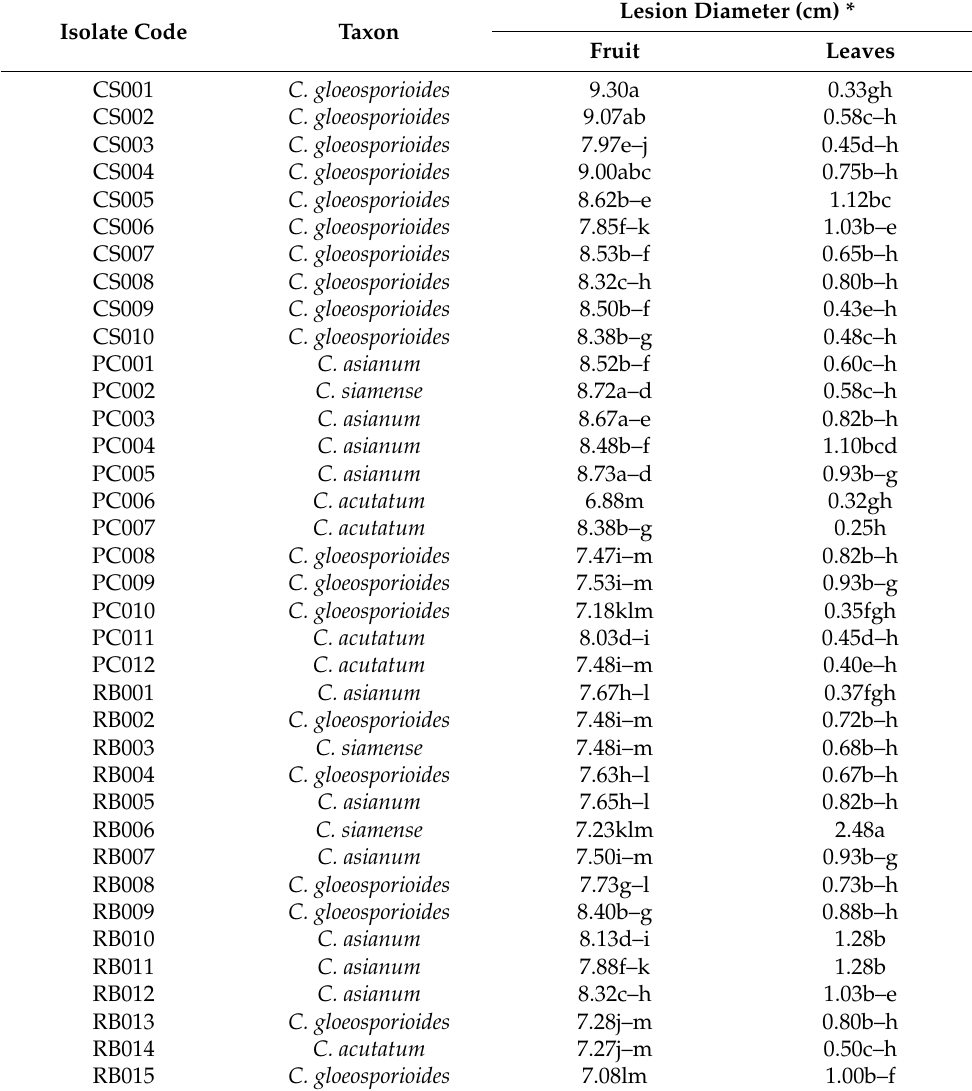
Table 2. Lesion sizes on NDMST mango fruit and leaves after inoculation by the 37 isolates of Colletotrichum